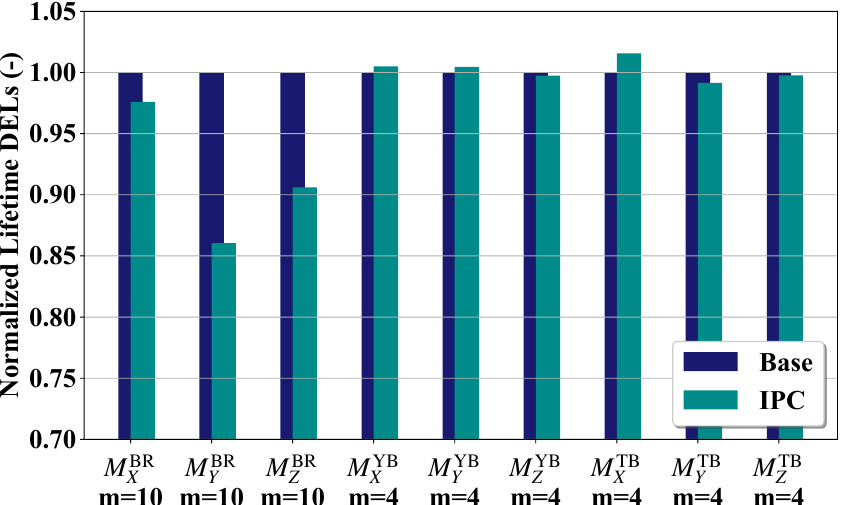
Figure 13. Normalized lifetime Damage Equivalent Loads (DELs) for considered sensors. Nomencla- ture is found in Table 5. Base = CPC